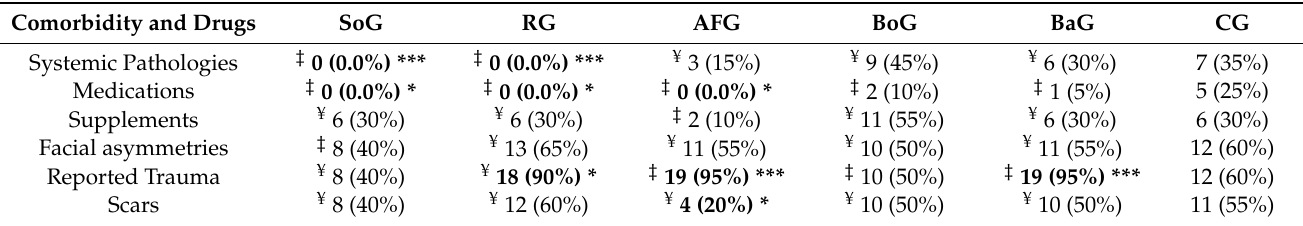
Table 2. Comorbidity and drugs: comparison between different sports and